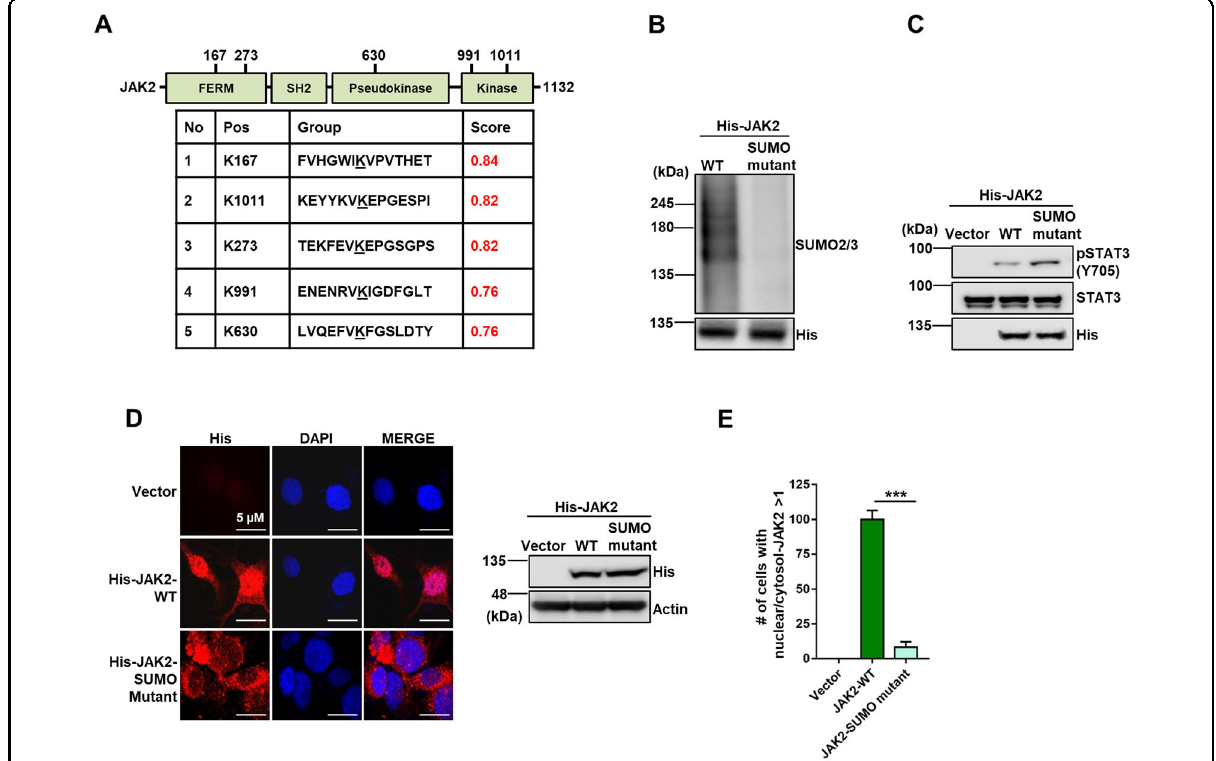
Fig. 3 JAK2 SUMOylation is required for STAT3 phosphorylation. A Schematic diagram of the distribution of putative JAK2 SUMOylation sites, predicted by SUMOplot ™ . The score indicates the probability. B JAK2-SUMO mutant clones 1 and 2 fails to be SUMOylated in vitro. Recombinant His- JAK2 proteins were used for in vitro SUMOylation assay as described in “ Materials and Methods ” . C JAK2-SUMO mutant phosphorylates STAT3 (Tyr705) in vitro. Empty vector, His-JAK2 and His-JAK2 SUMO mutant were puri fi ed from HEK293T cells, followed by in vitro kinase assay as in Fig. 2F. D JAK2-SUMO mutant accumulates in cytoplasm. Empty vector, His-JAK2 and His-JAK2 SUMO mutant were transfected in IGROV1 cells, followed by immuno fl uorescence assay using anti-His antibody. Scale bar: 5 µm. Right panel, expression of JAK2 and JAK2-SUMO mutant. E Quanti fi cation of cellular distribution of JAK2 in IGROV1 cells as shown in ( D ). In total, 100 cells were counted in each sample. ***, p <